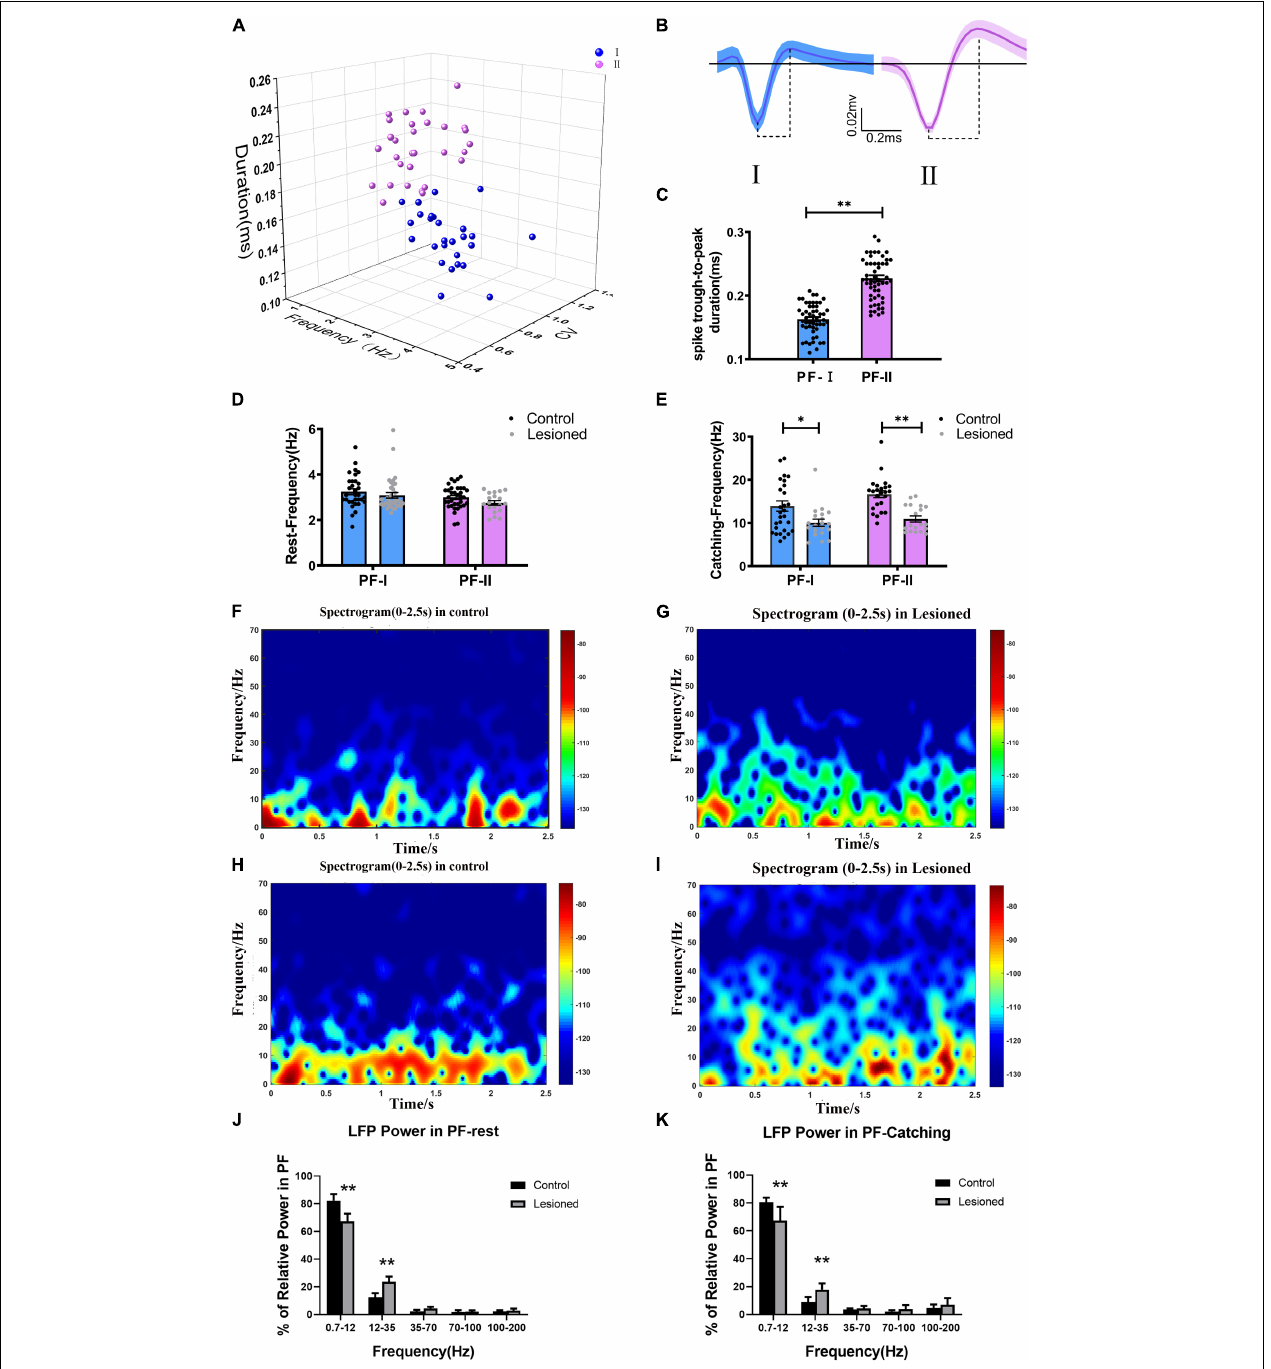
FIGURE 3 | Neuron classification in the PF and alterations in firing rate and LFP power for the two types of neurons. (A) Corresponding cluster analysis of all recorded neurons according to duration and firing properties in 3D view. (B) Waveforms of the two types of neurons in the PF (blue, type I; purple, type II). The dotted lines below the waveforms show their trough-to-peak durations. (C) Statistical results of the through-to peak durations of all recorded neurons between the two subtypes of neurons were different. (D) The bar and scatter plot showed the mean frequency from type I (the blue bar) neurons and type II neurons (the purple bar) during resting and (E) catching movement states respectively, with black dots for the control rats and gray dots for the 6-OH DA-treated rats. Spectrograms of LFP power from the PF in the (F) control rats and (G) lesioned rats during resting states. Spectrograms of LFP power from the PF in the (H) control rats and (I) lesioned rats during catching movement states. (J) Bar graphs show the mean relative LFP power from different frequency bands between the control rats (black bars) and the 6-OH DA-treated rats (gray bars) during resting and (K) catching movement states, respectively. Error bars represent SEM, ∗ indicates p < 0.05. ∗∗ indicates p <